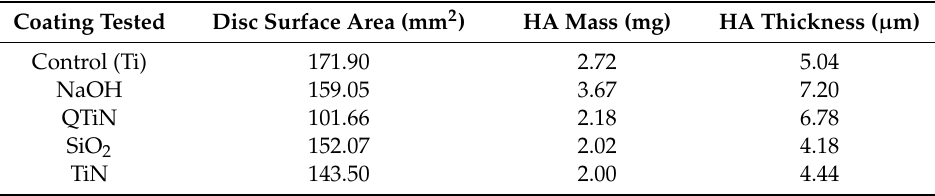
Table 4. Hydroxyapatite layer across the